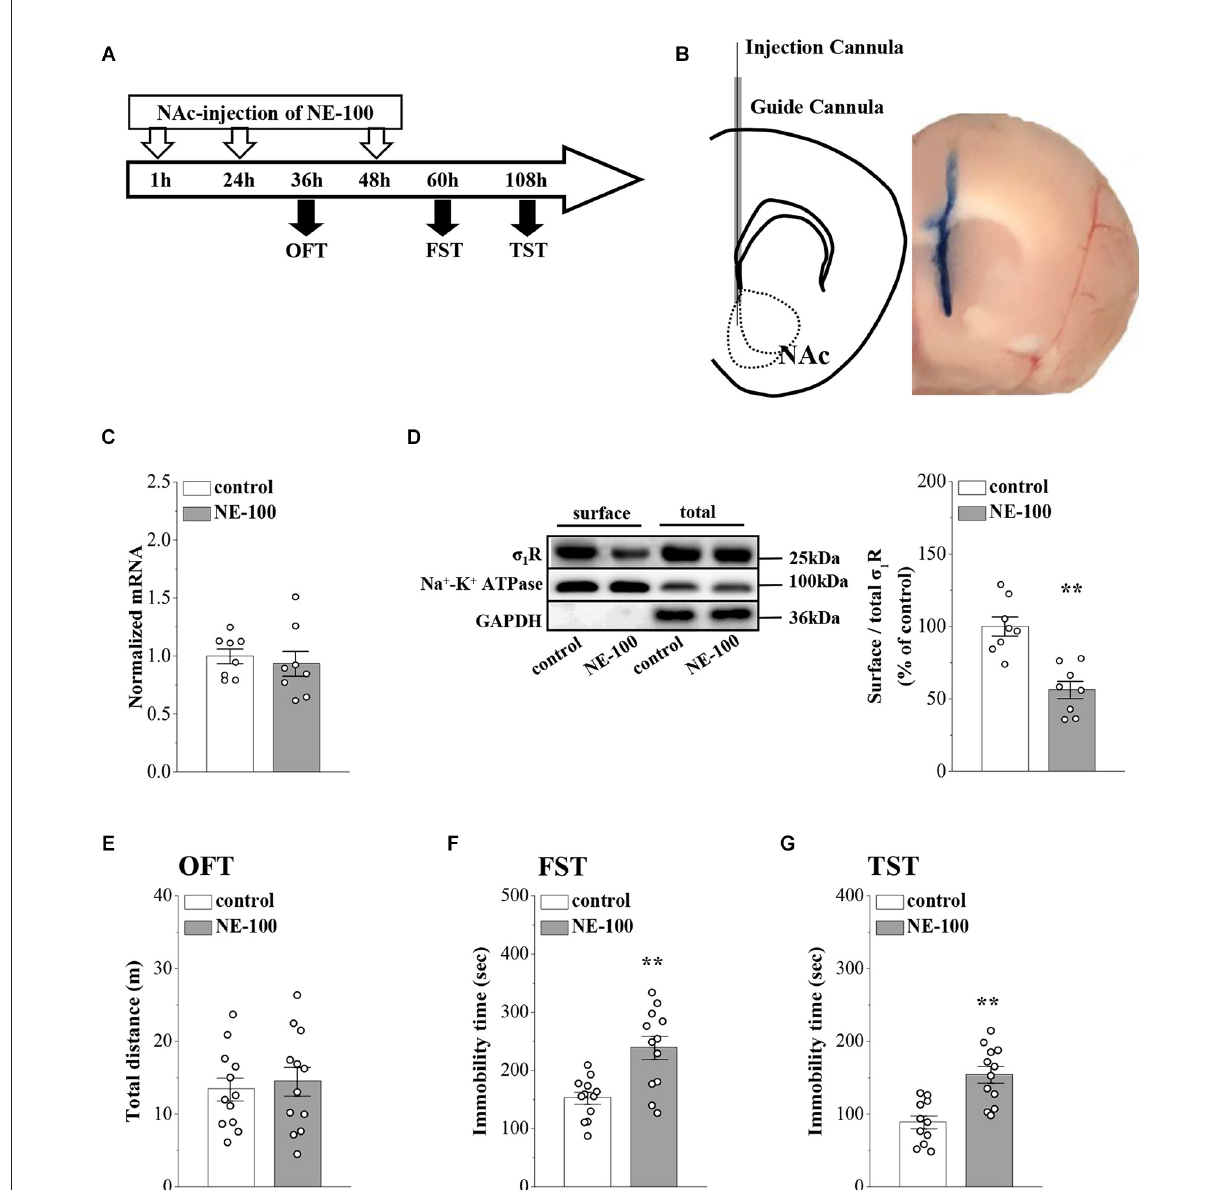
FIGURE1 Repeated injection of NE-100 in the NAc induces depressive-like behaviors. (A) The time course of the experimental procedure. (B) Schematic diagram of the NAc (left panel) and image of the NAc injected with Evans-blue (right panel). (C) The level of σ 1 R mRNA in the NAc was examined at the end of the behavioral tests ( n = 8 mice per group; Student’s t -test). (D) Representative Western blots of biotin-labeled surface proteins (surface) and total proteins (total) σ 1 R in the NAc. Na + -K + ATPase served as internal control and GAPDH served as a negative control. Bar graphs indicate the ratio of proteins at the cell surface to their total levels. ** p < 0.01 vs. control mice ( n = 8 mice per group; Student’s t -test). (E) Bar graphs show the distance traveled in OFT in control mice and NE-100 mice ( n = 12 mice per group; Student’s t -test). (F,G) Bar graphs show the immobility time of FST and TST in control mice and NE-100 mice. ** p < 0.01 vs. control mice ( n = 11 mice in control group of TST and n = 12 mice in other groups; Student’s t -test).